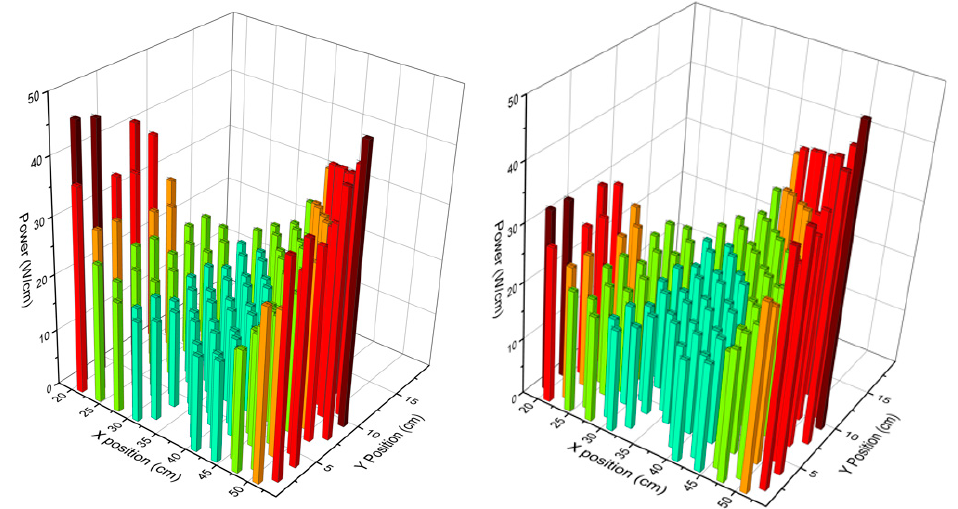
Figure 9. ( Left ) Power distribution with the central reflector fully inserted (undisturbed reference case); ( Right ) Power distribution with the central reflector fully